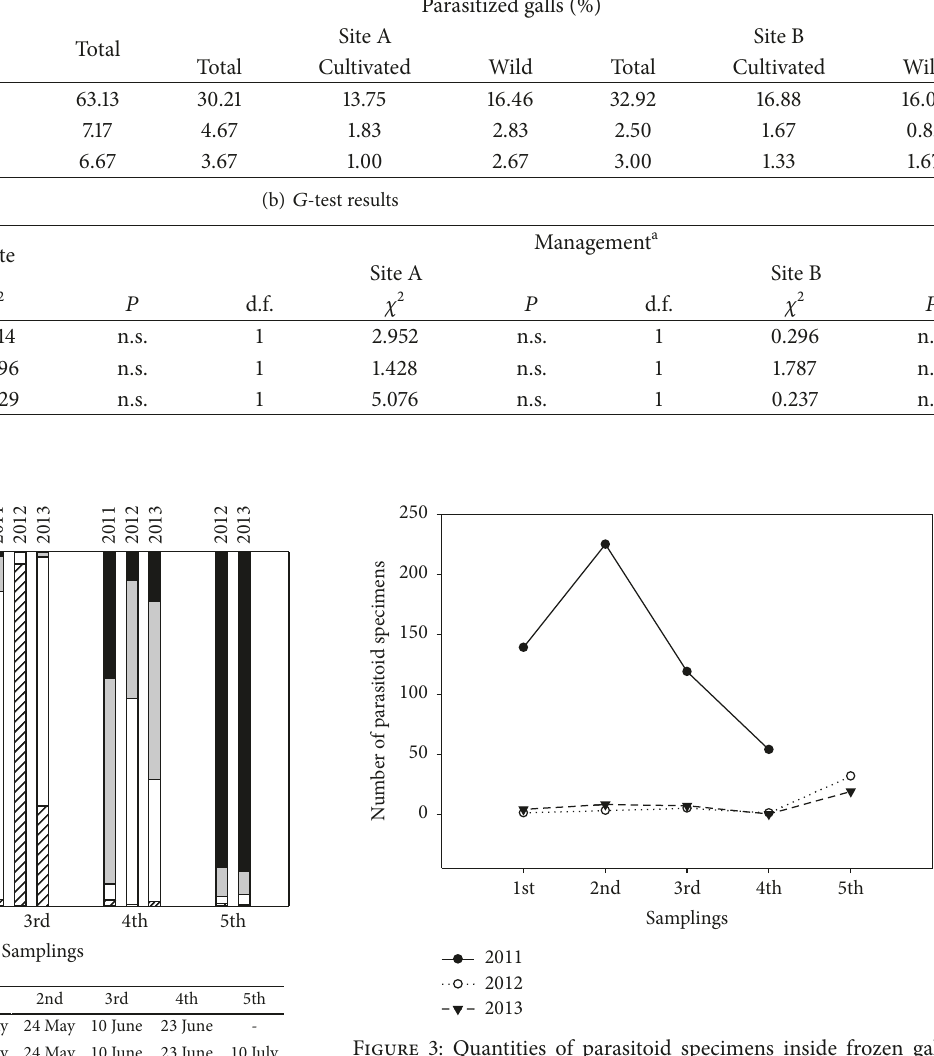
Figure 3: Quantities of parasitoid specimens inside frozen galls collected from cultivated and wild chestnuts in the two study sites (site A = 478 m a.s.l.; site B = 665 m a.s.l.) at Marradi (Italy) during the three-year